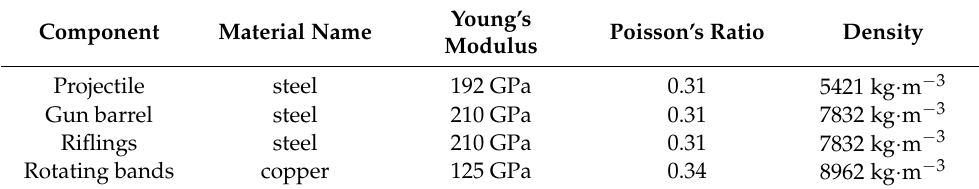
Table 2. Basic material parameters of finite element model.